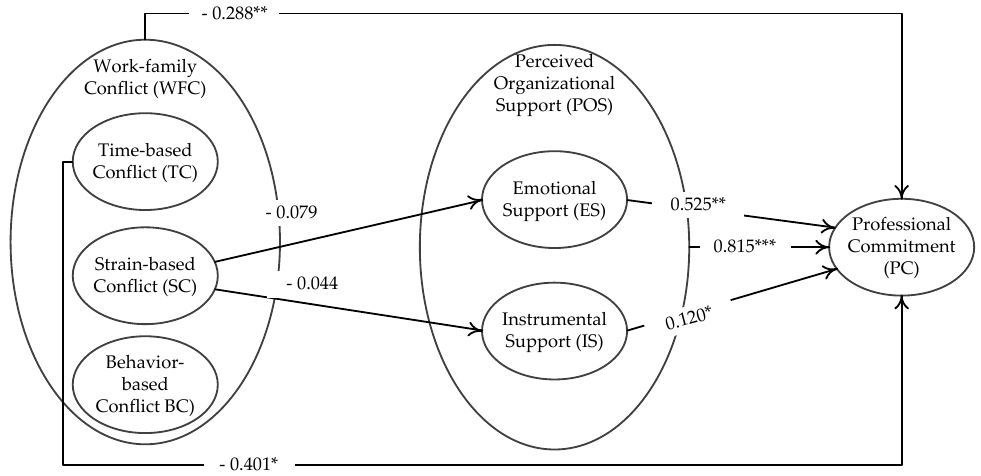
Figure 2. The hypothesis testing results of the theoretical model. Notes: the coefficients above the single arrow lines indicate the significant indirect effects. *** p < 0.001; ** p < 0.01; * p < Table 10. Results of hypothesis testing.